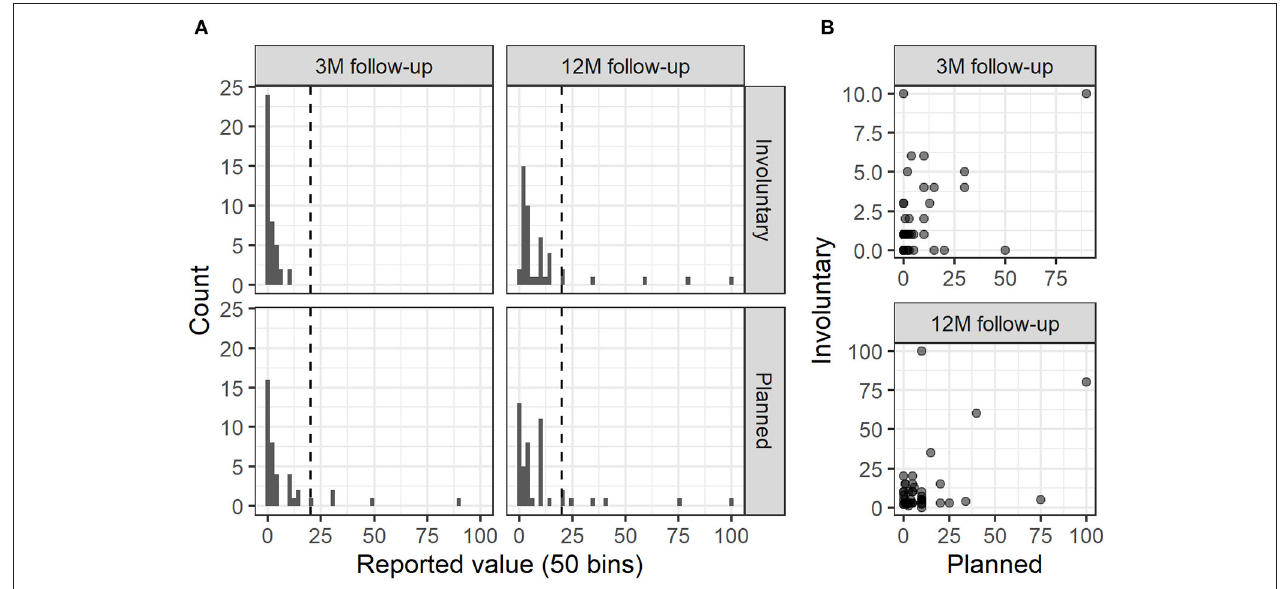
FIGURE 1 | Distributions and correlations of planned and involuntary exposure occasions across time. (A) Distributions of (raw) reported exposure occasions split by type and assessment point. Dashed line shows chosen outlier threshold. (B) Scatterplots of planned vs. involuntary exposures split by assessment point.